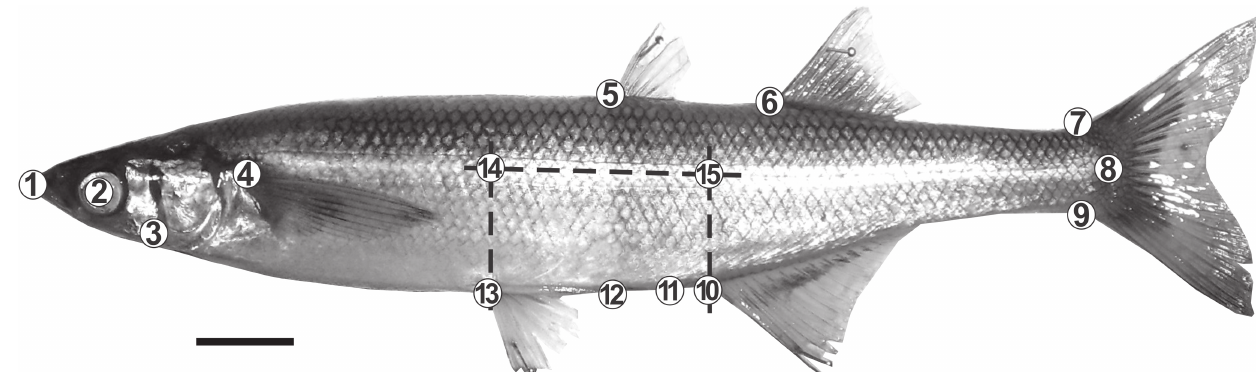
Fig. 2. Landmarks used in geometrics morphometrics analysis: 1, anterior tip of the premaxilla; 2, eye center; 3, posterior process of symplectic bone; 4, dorsal insertion of the pectoral fin; 5, anterior insertion of the first dorsal fin; 6, anterior insertion of the second dorsal fin; 7, dorsal insertion of the caudal fin; 8, posterior end of the lateral line; 9, ventral end of the caudal fin; 10, anterior insertion of the anal fin; 11, anus; 12, distal tip of the pelvic fin onto fish body; 13, anterior insertion of the pelvic fin; 14, vertical tie of landmark 12 onto the lateral line; 15, vertical tie of landmark 10 onto the lateral line. Black line scale: 2